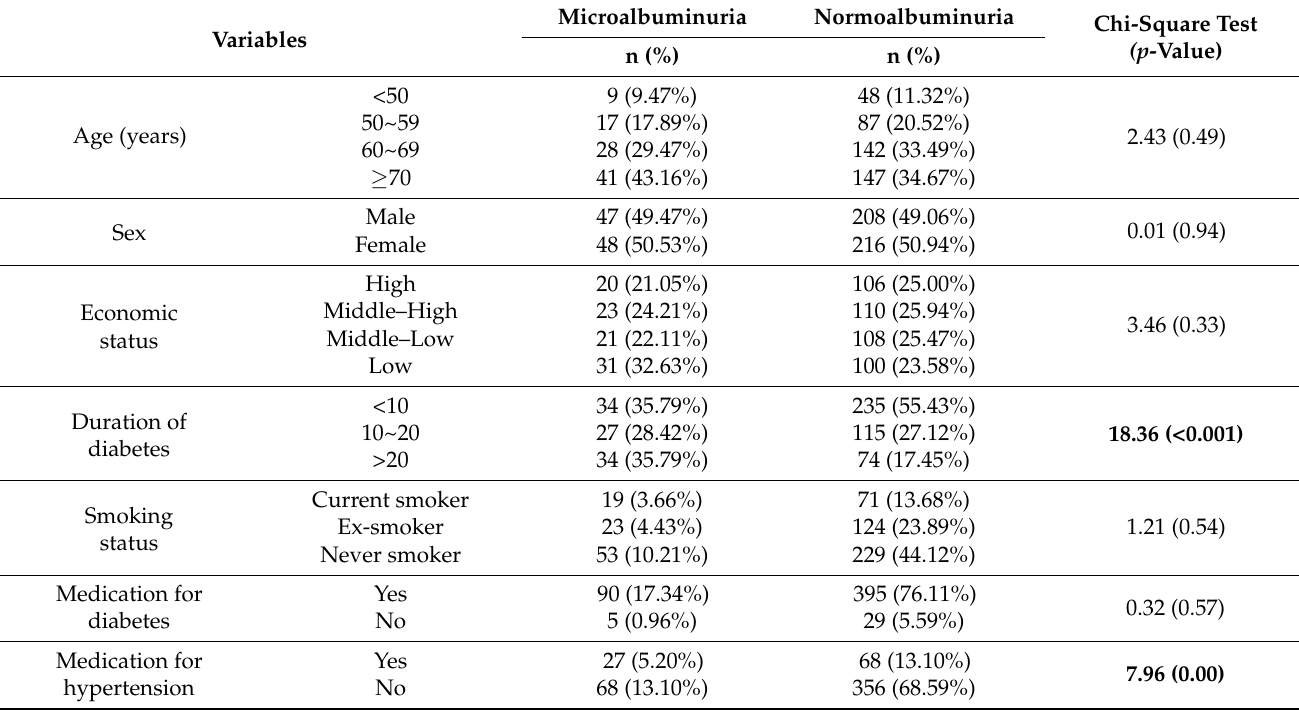
Table 1. General characteristics of the participants according to microalbuminuria status. Microalbuminuria Normoalbuminuria Chi-Square Variables